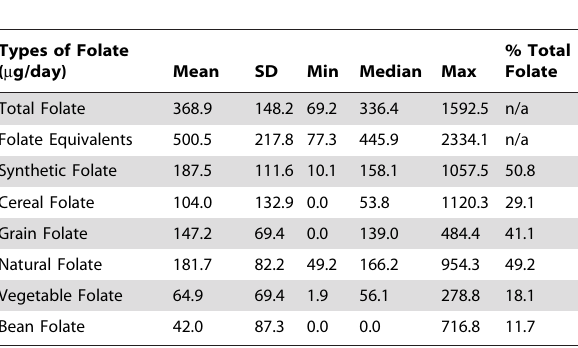
Table 2. Intake of Folate by Type and Source in Women of the BioCycle Study.